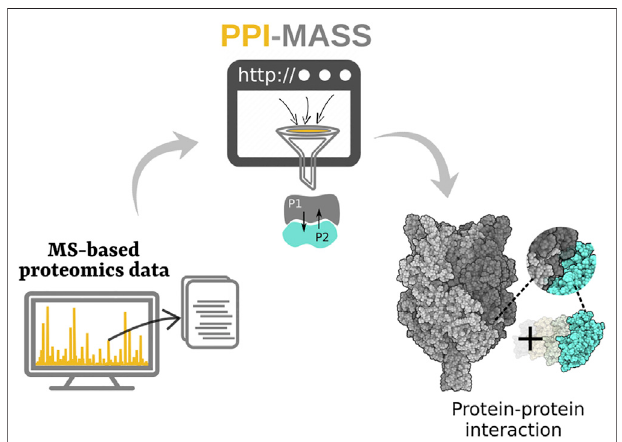
FIGURE 3 | Schematic representation of the PPI-MASS web server acting as a computational interface to process MS-based proteomics data and to predict a structural model of protein-protein